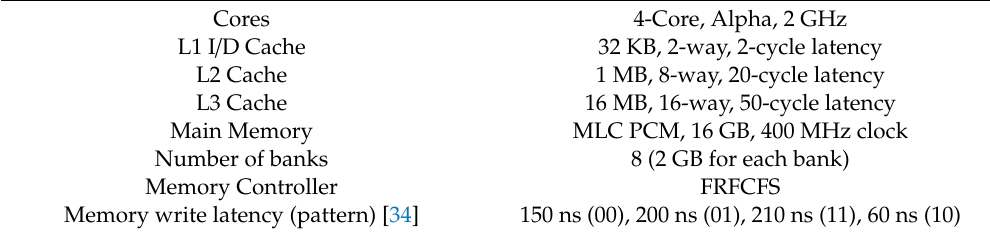
Table 5. Simulation parameters.